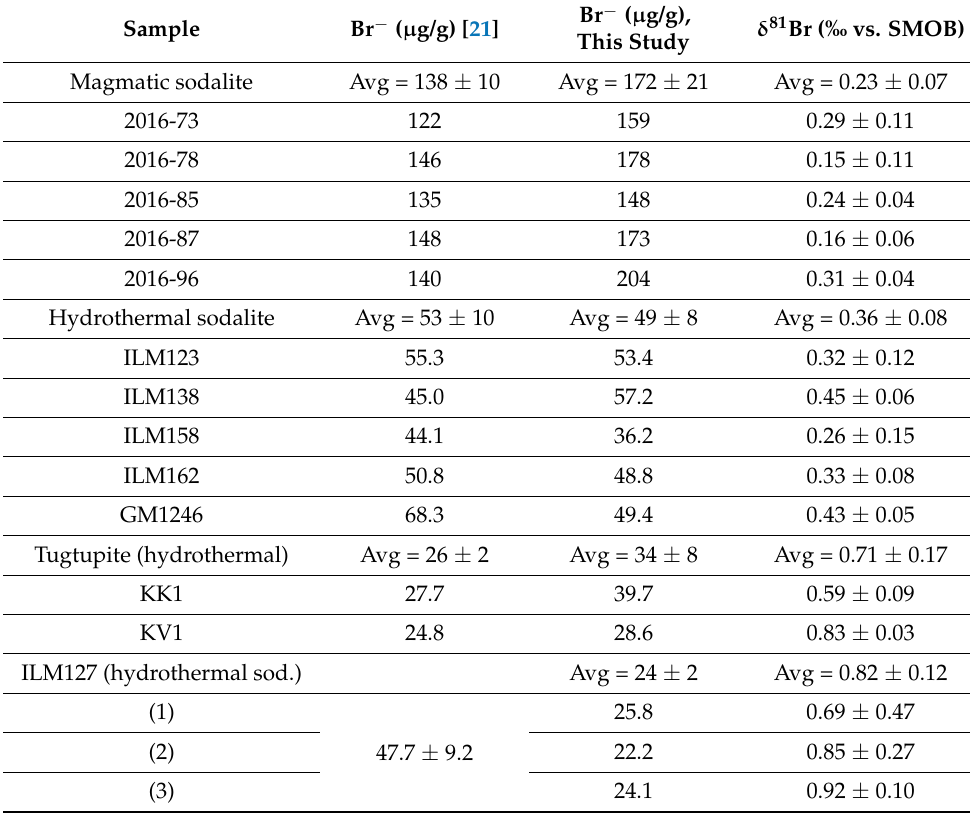
Table 1. Results of the Br determinations and δ 81 Br measurements of the sodalite and tugtupite samples measured in this study, based on ion-chromatography after HNO 3 extraction. Data in the row after the names of the sample groups are averages ± the standard deviations of the Br − and δ 81 Br values of all samples within each sample